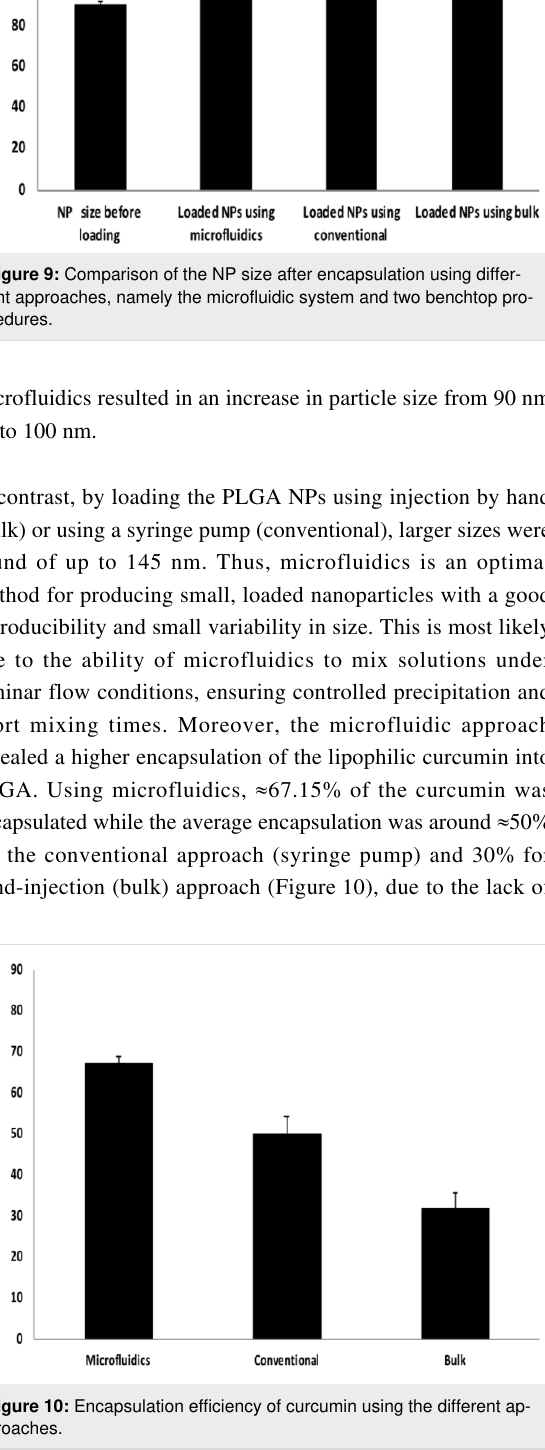
microfluidics resulted in an increase in particle size from 90 nm up to 100